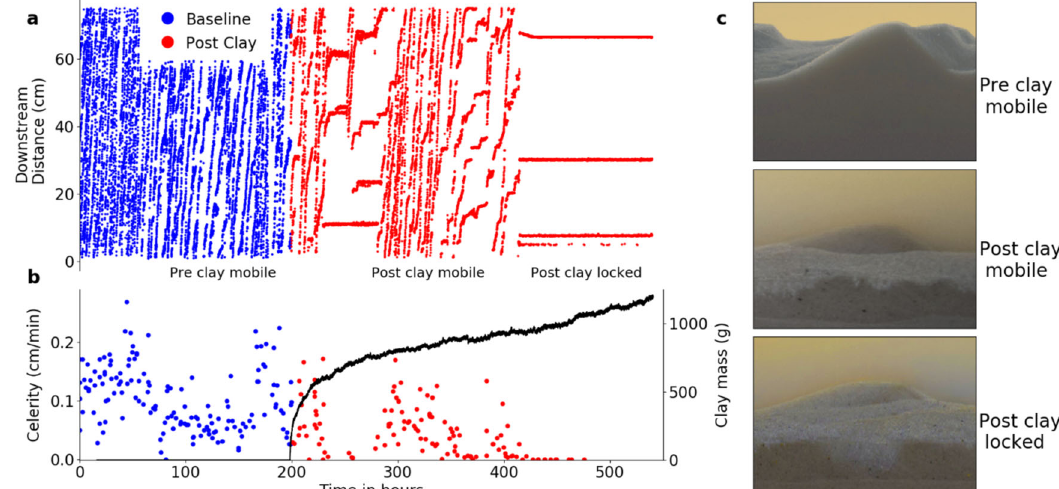
Fig. 1 Temporal evolution of bedforms towards a locked end state. a Bedform troughs were continuously tracked both before (blue) and after clay additions (red). After the addition of clay, bedforms slow and eventually lock in place. Red horizontal lines indicate immobile bedforms (i.e., celerity = 0). b Red and blue points represent bedform celerities calculated for the trough locations shown in a , while the solid black line represents the accumulation of clay within the bed. As the clay accumulates, the bed temporally locks (celerities approach zero near 250 h) and then bed movement restarts due to upstream turbulent fl uctuations. The bed relocks after suf fi cient clay accumulates in the bed (near 410 h). c From top to bottom, images showing clean bed mobile bedforms (50 h), post clay addition partially mobile bedforms (300 h), and locked bedforms (450 h), respectively. Images have been color matched to aid in visualization of the clay layer. Under conditions of high bed sediment transport rates, ongoing sand transport leads to a segregated end state with mobile bedforms propagating over a layer of deposited clay. However, in cases dominated by stabilization, extensive clay deposition within bedforms produces a locked end